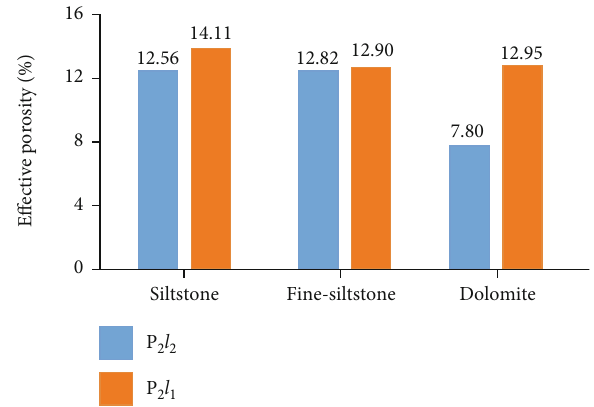
Figure 4: E ff ective porosity (%) of each lithology in the upper and lower sweet